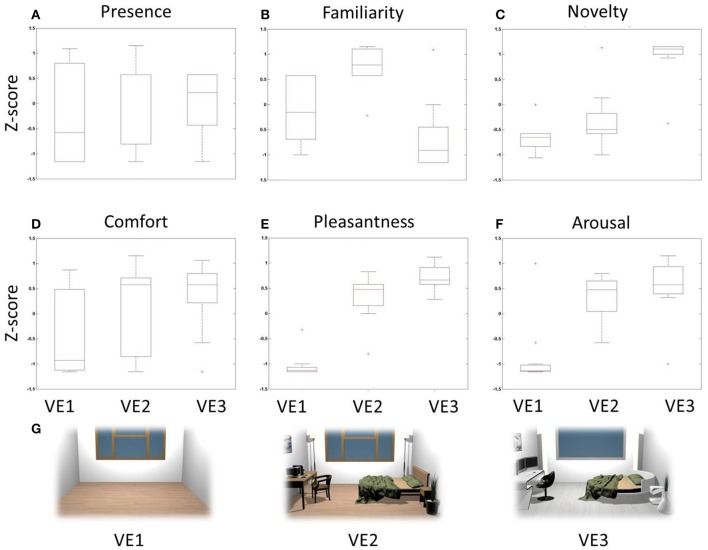
Z-score boxplots of behavioral judgments among VEs. Each panel contains three boxplots related to the distribution of behavioral scores for VE1 (left), VE2 (center), and VE3 (right). On each box, the central mark is the median, the edges of the box are the 25th and 75th percentiles, the whiskers extend to the most extreme data points. Red crosses indicate outliers of the distribution. (A) Presence, (B) Familiarity, (C) Novelty, (D) Comfort, (E) Pleasantness, (F) Arousal, (G) Two-dimensional rendering of the three VEs designed and used for the stimulation.